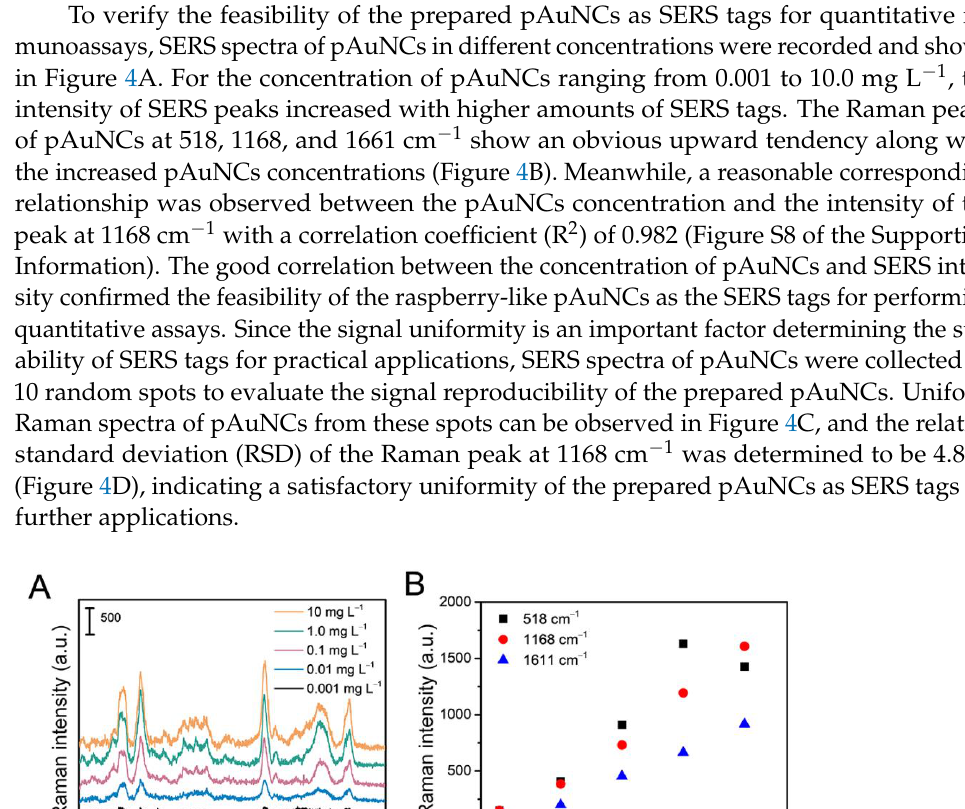
further applications.